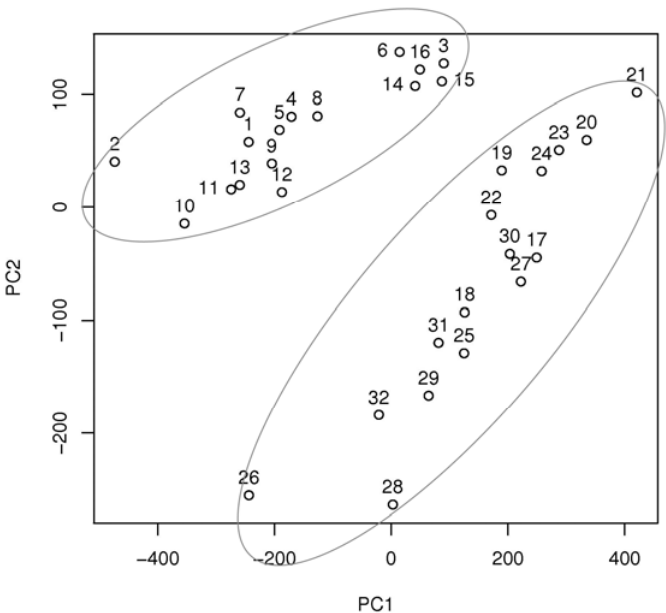
Figure 8. Principal component analysis (PCA) of ATR-FT-IR spectra of 32 analyzed AChE inhibitors.